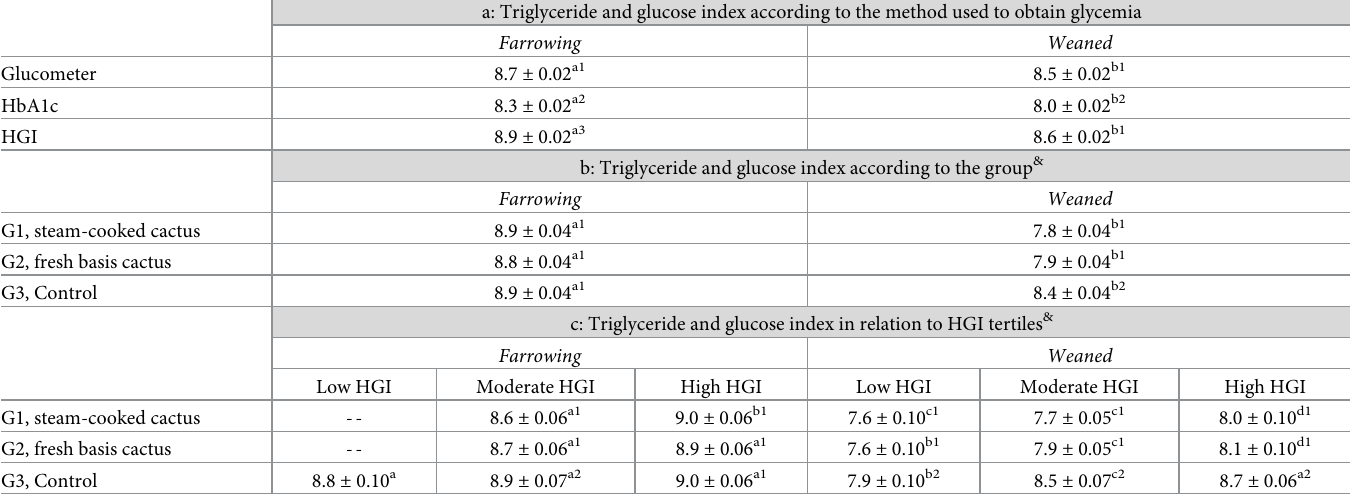
Table 4. Least squares mean ( ± SEM) for the average values of the triglyceride and glucose index (Ln) according to: a, the method used to obtain glycemia (mg/dL) concentrations; b, according to the group and; c, in relation to HGI tertiles. a: Triglyceride and glucose index according to the method used to obtain glycemia Farrowing